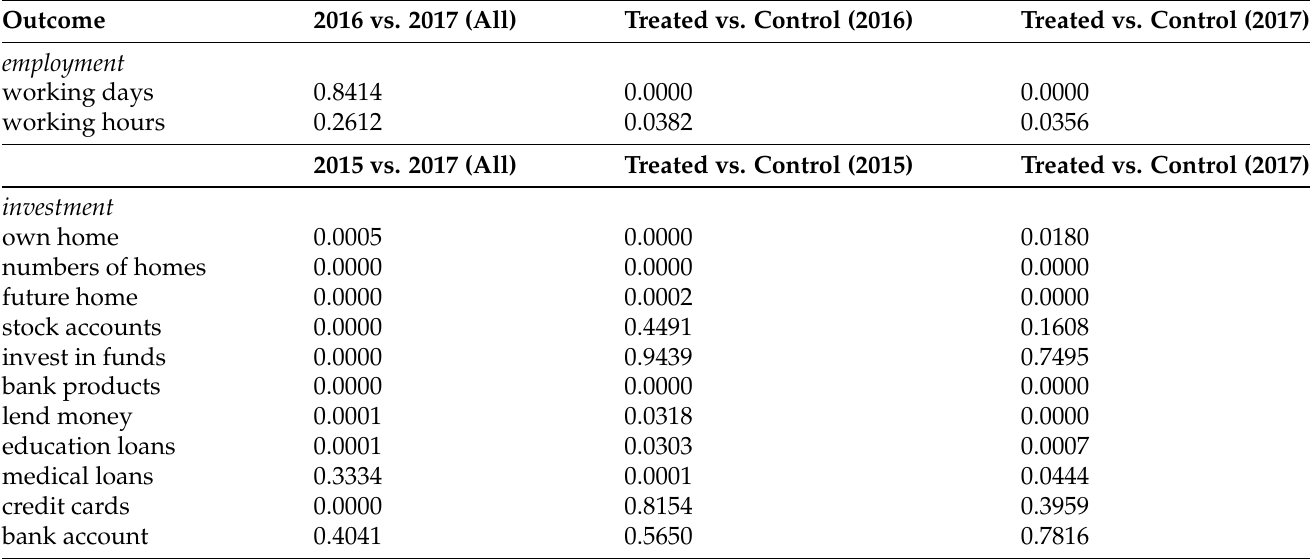
Table 3. Wilcoxon rank-sum test for differences between means over time and between treated and control groups: each number refers to the p -value for the associated test (description of each outcome variable can be found in Table